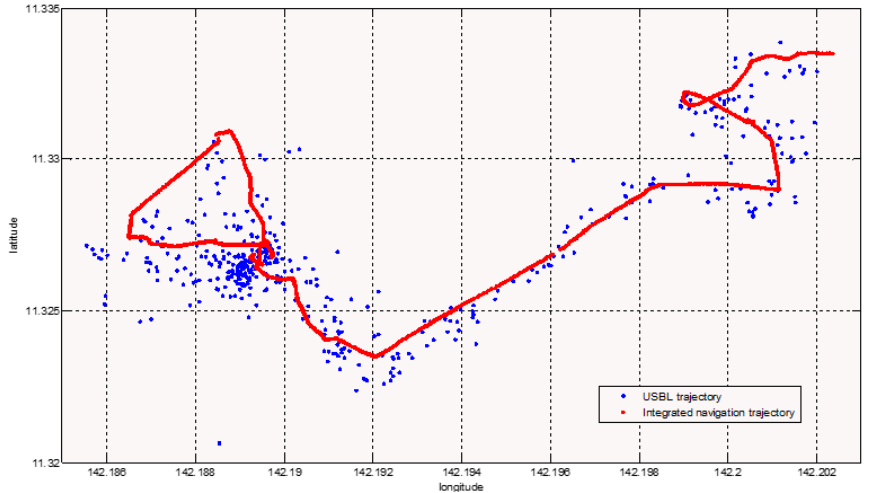
Figure 21. Track of the Fendouzhe HOV.